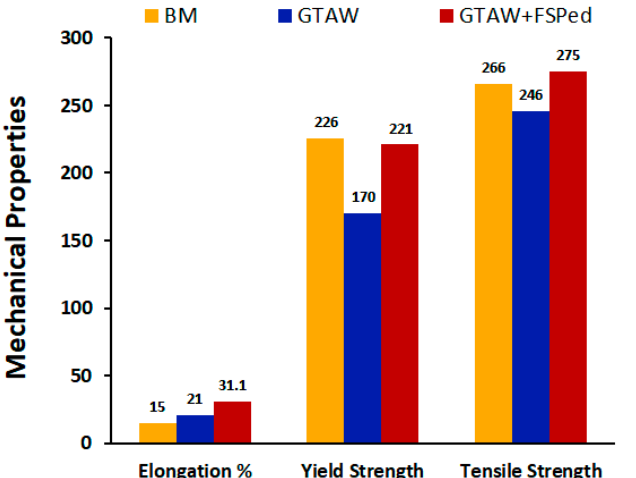
Figure 11. The yield strength, ultimate tensile strength (UTS), and elongation of the base material, unprocessed weldment, and friction-stir-processed welds.